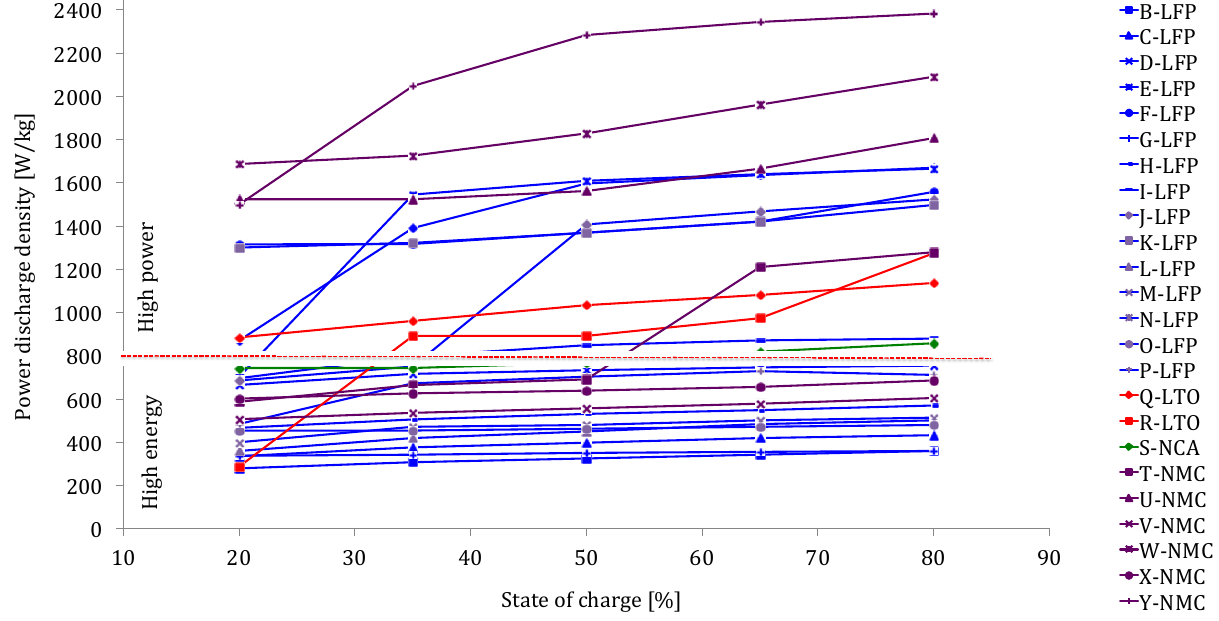
Figure 24. Power capabilities of lithium-ion batteries at different SoC levels.